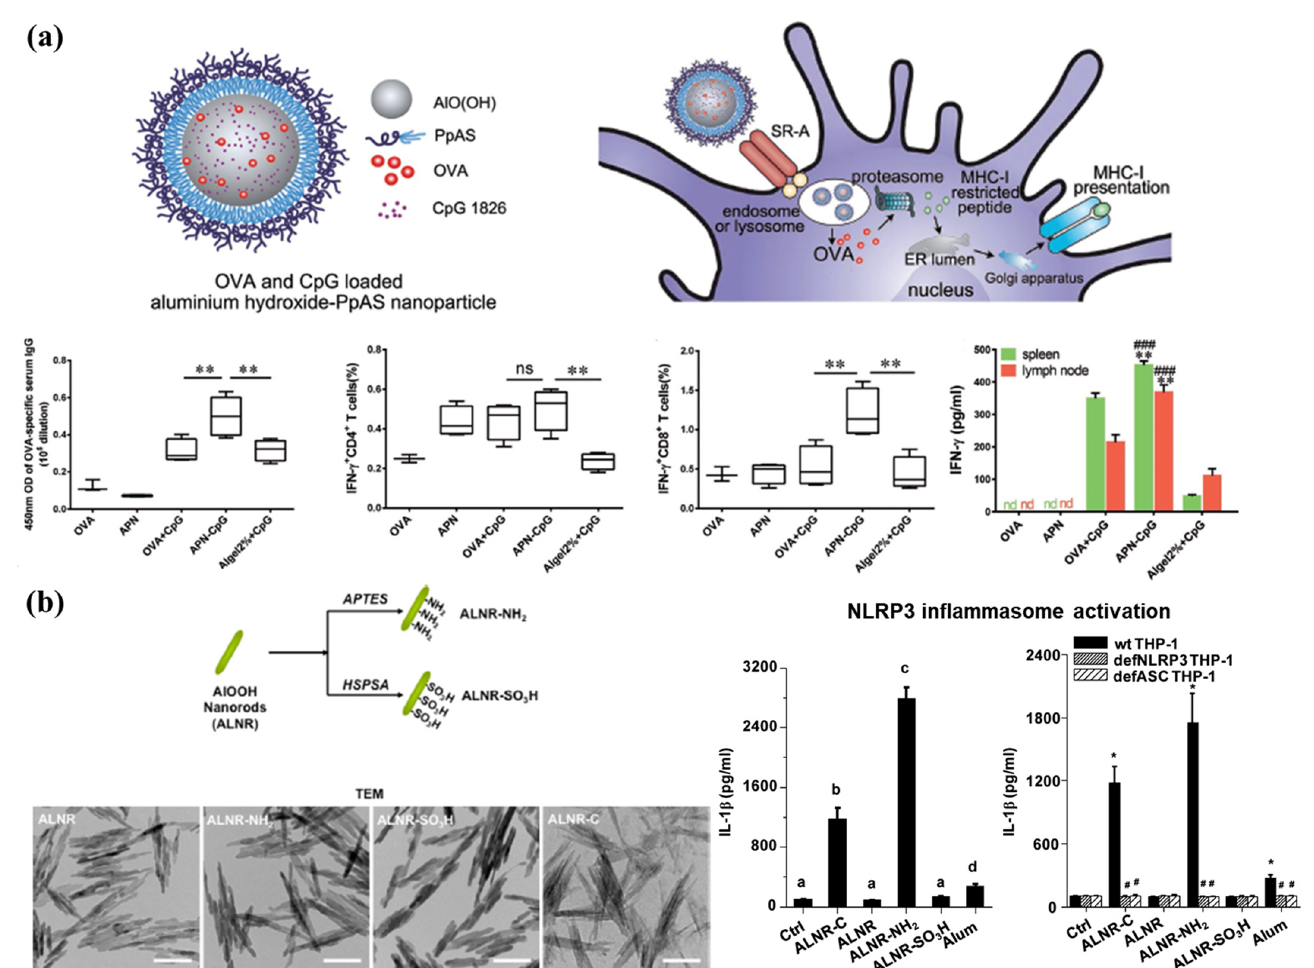
Figure 4. Nanoparticulate aluminum-based adjuvants. ( a ) Schematic representation of aluminum hydroxide-PpAS nanoparticles (APNs) adsorbing OVA and CpG. APNs promote antigen cross-presentation via a cytosolic pathway in dendritic cells. Enhanced antigen-specific humoral and cellular immune responses after immunization with APNs. Statistical analysis was performed using one-way ANOVA, followed by the Bonferroni post-test. * p < 0.05; ** p < 0.01; # p < 0.05; ### p < 0.001; ns, not significant; nd, not detectable. Reproduced with permission from [132]. Copyright (2018) American Association for Advancement of Science. ( b ) Schematic of the surface charge functionalization of aluminum oxyhydroxide [AlO(OH)] with APTES and HSPSA. Representative TEM images of ALNR, ALNR-NH2, ALNR-SO3H and ALNR-C, where the scale bars was 200 nm. NLRP3 inflammasome activation after treatment with ALNR has also been shown. Statistical analysis was performed using Tukey’s test. The values that do not share the same letter indicate statistical differences at p < 0.01. Reproduced with permission from [131]. Copyright (2017) American Chemical Society.